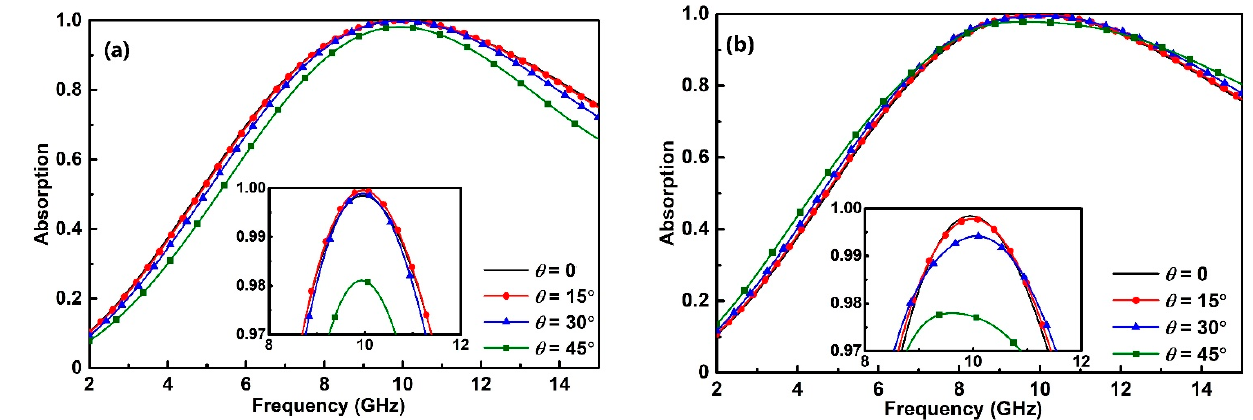
Figure 7. Absorption spectra around 10 GHz for the ( a ) TE and ( b ) TM polarization according to different incident angles.